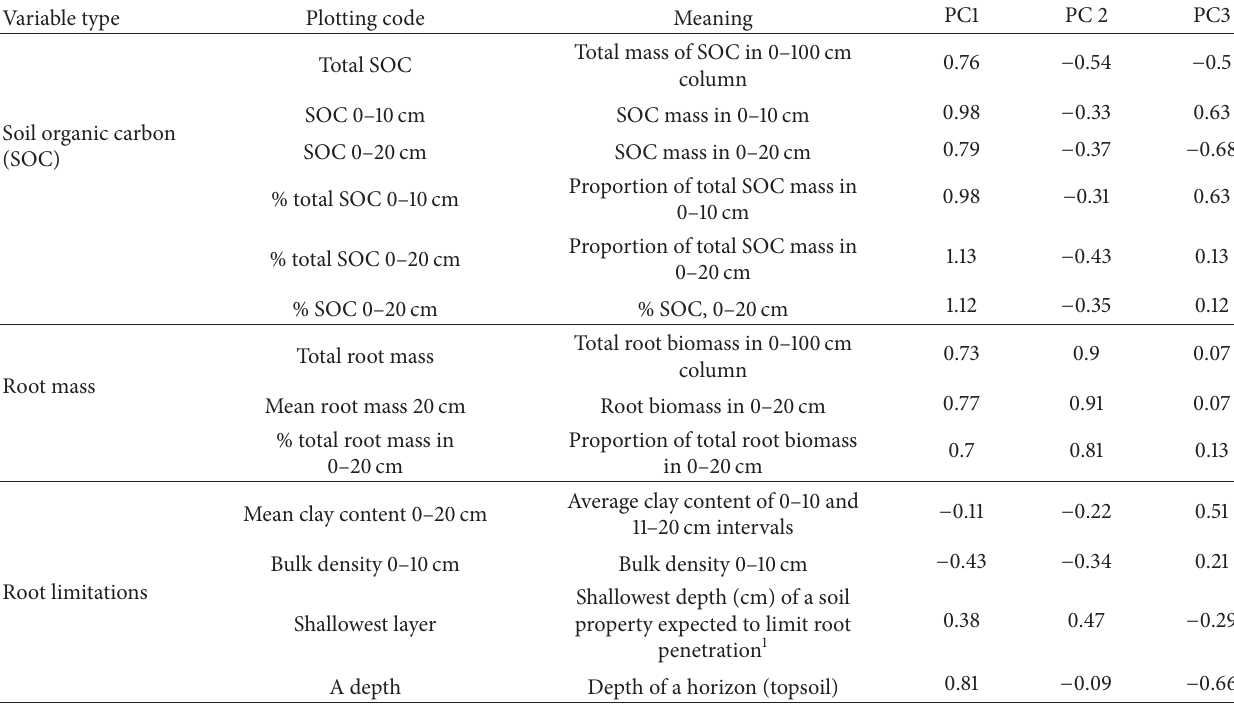
Table 5: Loadings along first three Principal Components (PC1, PC2, and PC3) for 13 belowground properties measured from six pastures in the Grand River Grasslands of Ringgold County, IA, and Harrison County, MO, USA. Plotting code refers to plotted text in Figure